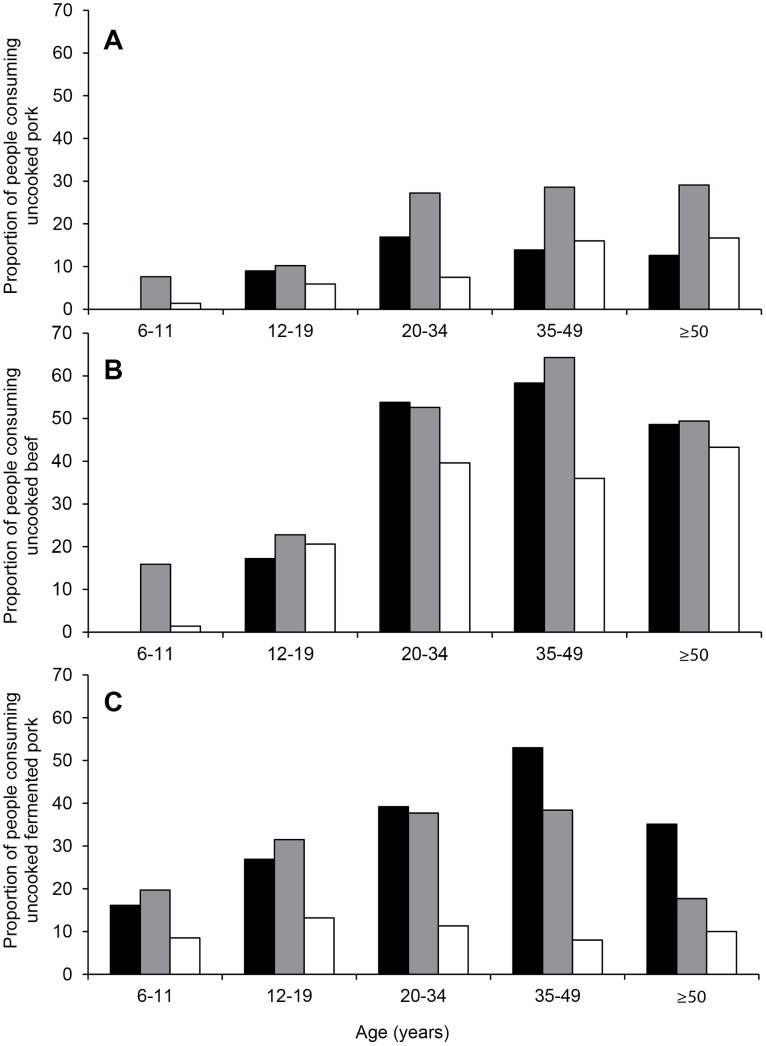
A-C, Proportion of the survey population reporting consumption of uncooked pork, uncooked beef and uncooked fermented pork, respectively, by age and ethnicity.Black columns, Lao-Tai ethnic group; Grey columns, Mon-Khmer ethnic group; and white columns, Hmong-Mien ethnic group.